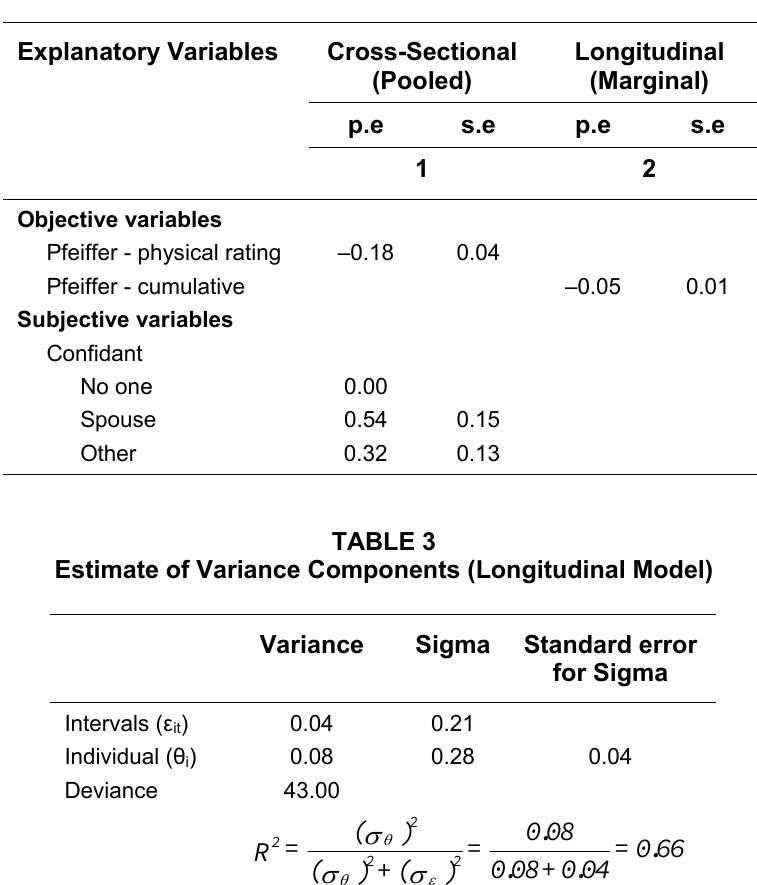
Summary of Results from Pooled Cross-Sectional and Longitudinal